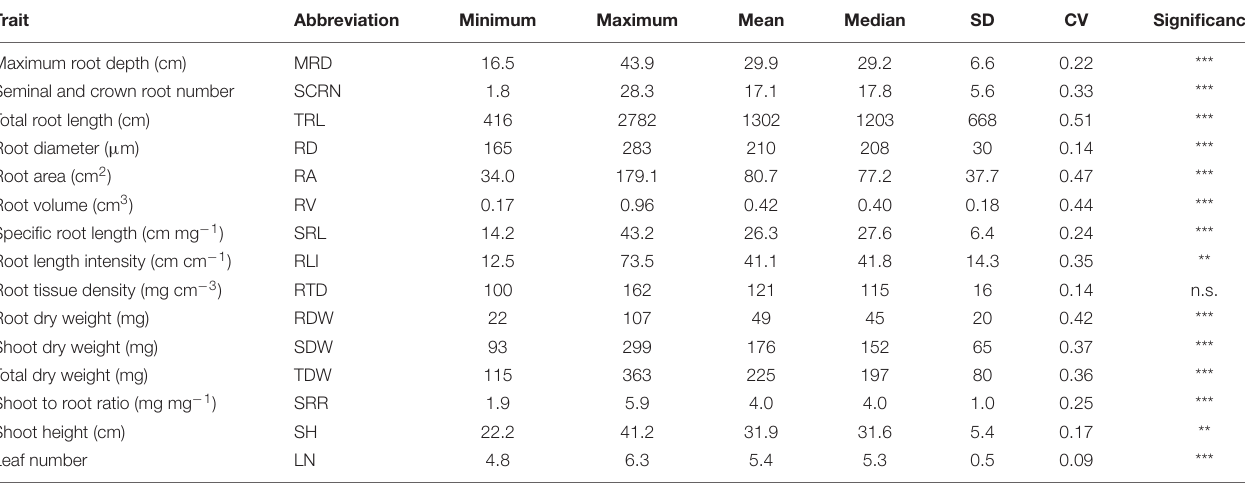
TABLE 3 | Descriptive statistics of 15 major traits in 20 rice genotypes grown in a semihydroponic phenotyping system for 55 days after transplanting. Trait